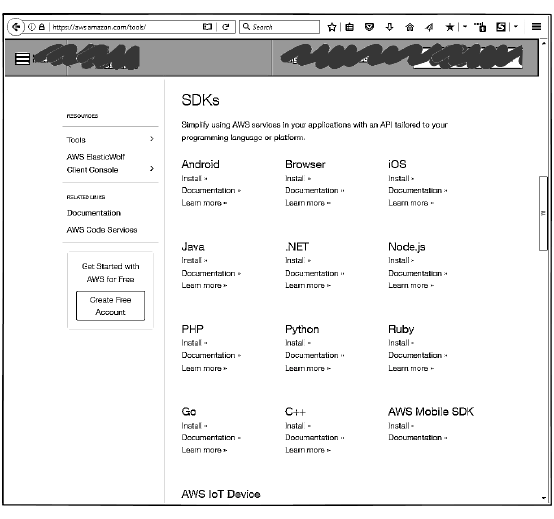
Fig. 13. Provided SDKs to use AWS services in all supported runtime environments.